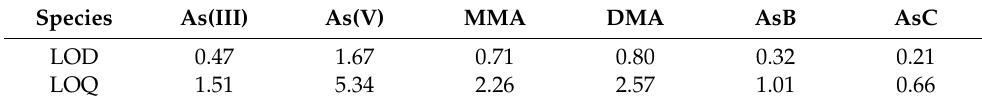
Table 6. Limits of detection and quantification of arsenic species (ng g − 1 ).